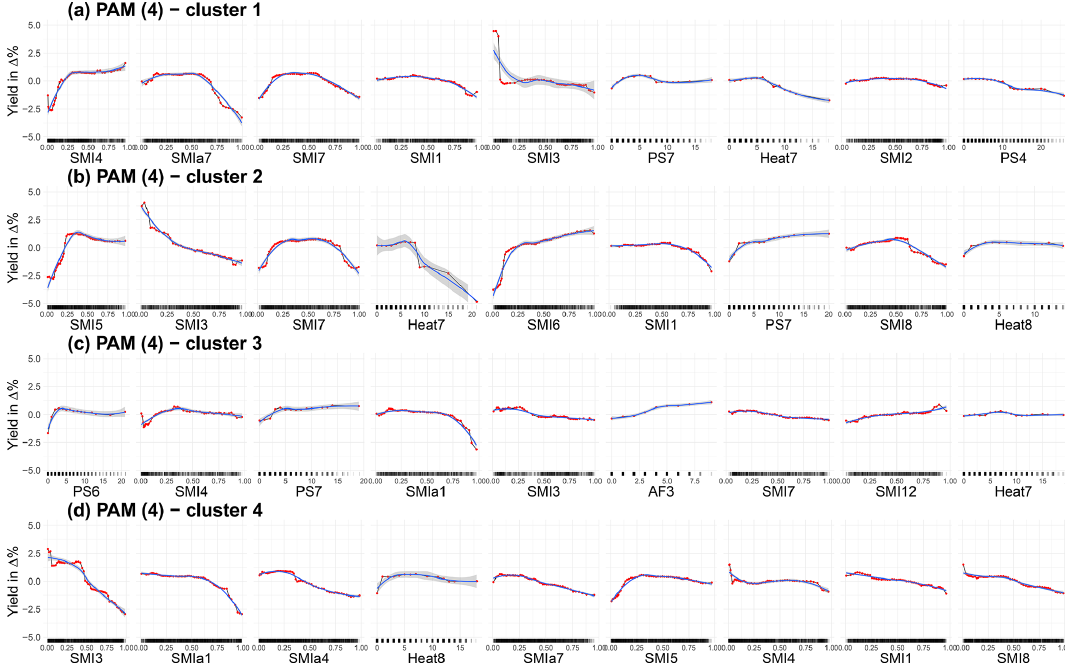
Figure A8. ALE plots for the second best combination of cluster algorithm and cluster size (PAM with four clusters) for a soil moisture index configuration that considers both the uppermost 25cm as well as the entire soil column. For the four clusters, the nine ALE plots with the highest feature importance are shown. The importance ranking is established with 50 repetitions. We have chosen a grid size of 50 to estimate the ALE plots, which allows us to reveal the true complexity of the model at the expense of shakiness. Therefore a non-linear smoothing function (LOESS – locally estimated scatterplot smoothing) is added in blue (with the confidence interval in grey). SMI represents the soil moisture index for the uppermost 25cm of the soil column, PS stands for days without rain in a given month, and Heat stands for days with a maximum temperature of more than 30 ◦ C. The number indicates the month; October (10) to December (12) refers to the year before.